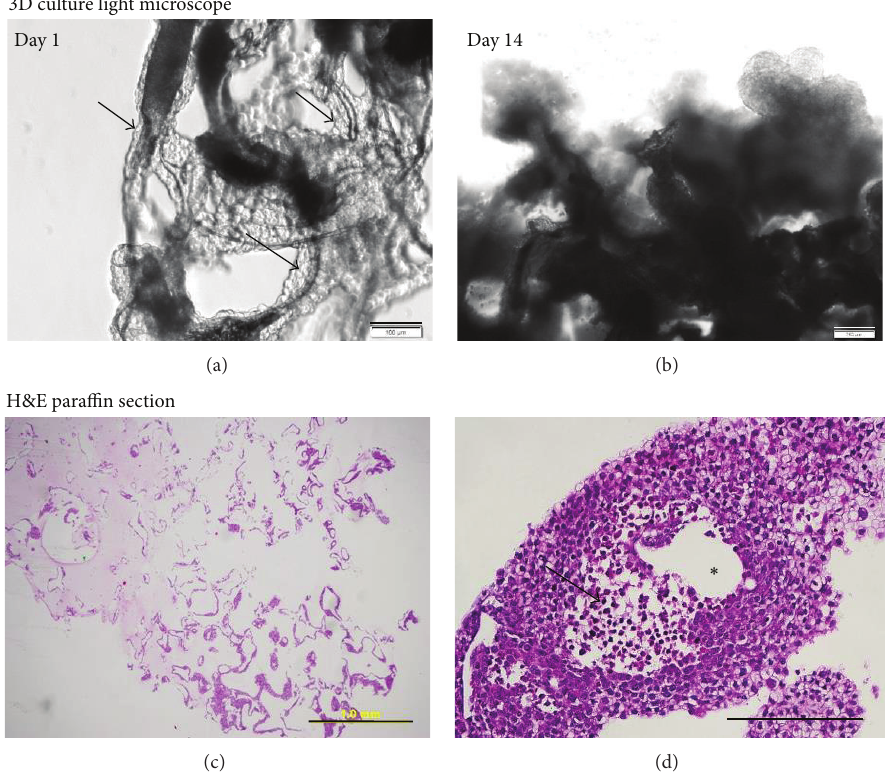
Figure 4: The top row shows light microscope images of NCI-H460 3D culture. (a) (Day 1) demonstrates cells (shown by arrows) that surround the scaffold (dark-shaded areas). This can be compared to (b), which shows that at day 14 multilayers of cells cover the scaffold. The bottom row shows images of H&E staining on paraffin sections of 3D culture after 1 week in culture. (c) shows the complete cross section of a scaffold with most of the large clumps located peripherally (magnification 4x). (d) is an example of a big cluster more than 500 𝜇 m in diameter, including a nonviable cell centre region (shown by arrow). The clear region that is marked with an asterisk ( ∗ ) shows the location of the scaffold that dissolved in xylene (magnification 20x). Scale bars are (a) 100 𝜇 m, (b) 200 𝜇 m, (c) 1mm, and (d) 200 𝜇